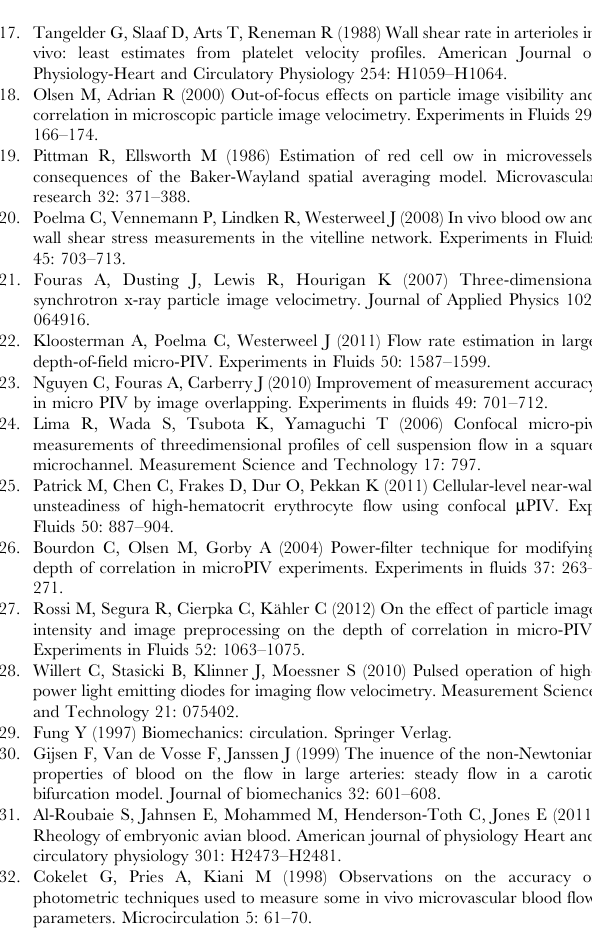
Figure S1 In silico PIV model: acquiring particle images and their cross-correlation function. ( Left ) Raw image of 1.28 m m tracer particles taken at z ~{ 116 m m , which here coincides with the focal plane. ( Right ) Autocorrelation of the particle images (inverted). NB: not to scale. Figure S2 In silico PIV model: shifting the autocorrela- tion using known velocity profile. ( Left ) Stack of autocor- relation functions. ( Middle ) Velocity profile. ( Right ) Displaced correlation functions. The dashed lines marked by ‘A’ and ‘B’ are also shown in figure 13 and represent contributions from in-focus (centerline, B) and out-of-focus (near wall, A) particle images.